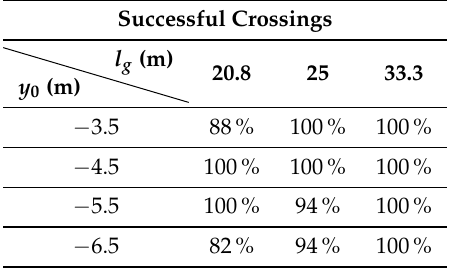
Table 2. Proportion of successful crossings to all crossing attempts for several values of y 0 and l g , when v c = 30 km/h and vehicle type is sedan.